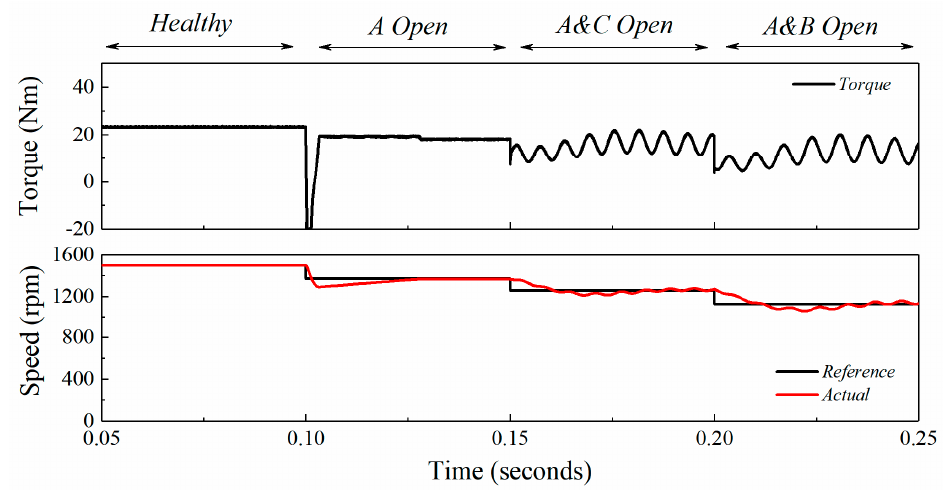
Figure 13. Torque and speed profiles in case of healthy and one- and two-phase fault operation.